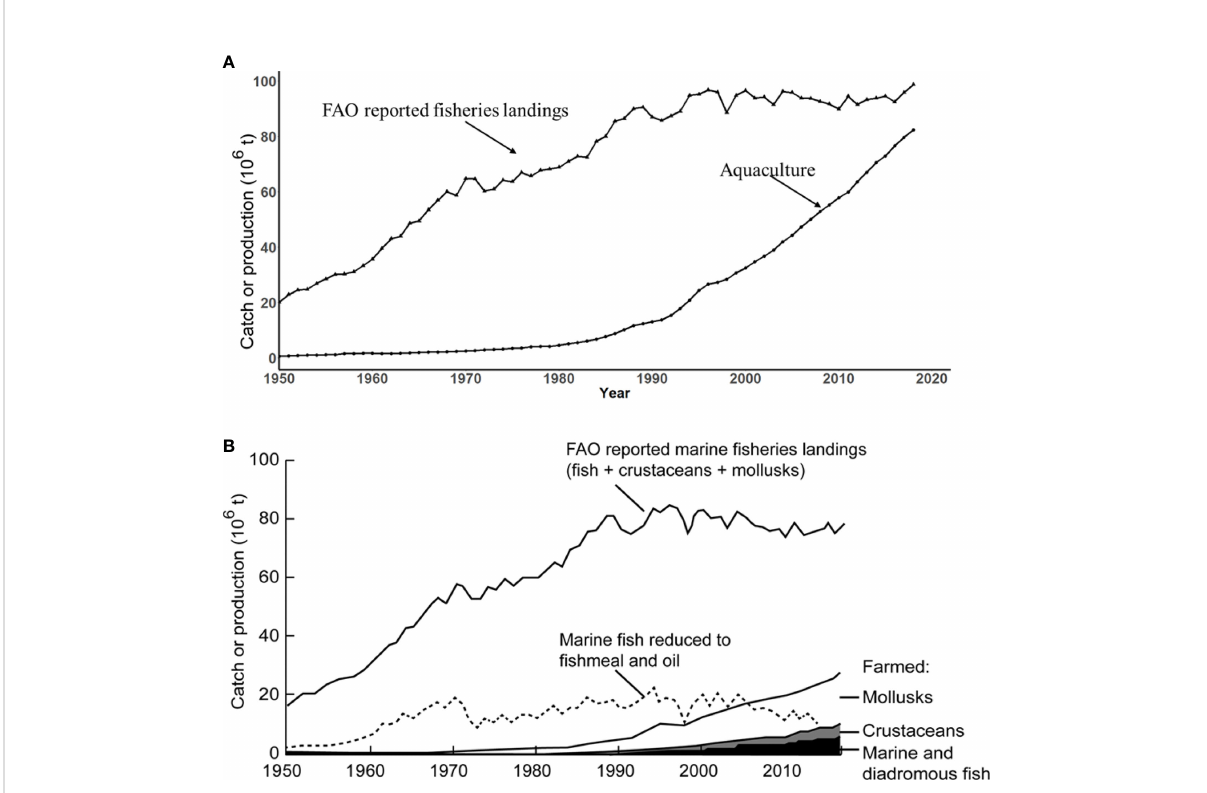
FIGURE 1 Comparison between fi sheries catches and aquaculture. (A) Global food fi sh production from aquaculture and fi sheries; (B) Comparison between the magnitudes of global marine fi sheries catches (from FAO) and the production of marine and diadromous fi sh (incl. salmon) and invertebrates (crustaceans and molluscs) through mariculture. Note that molluscs (mostly bivalves farmed in China) need no feed, but that farmed fi sh and crustaceans do, with feeds based on fi sheries catches (dotted